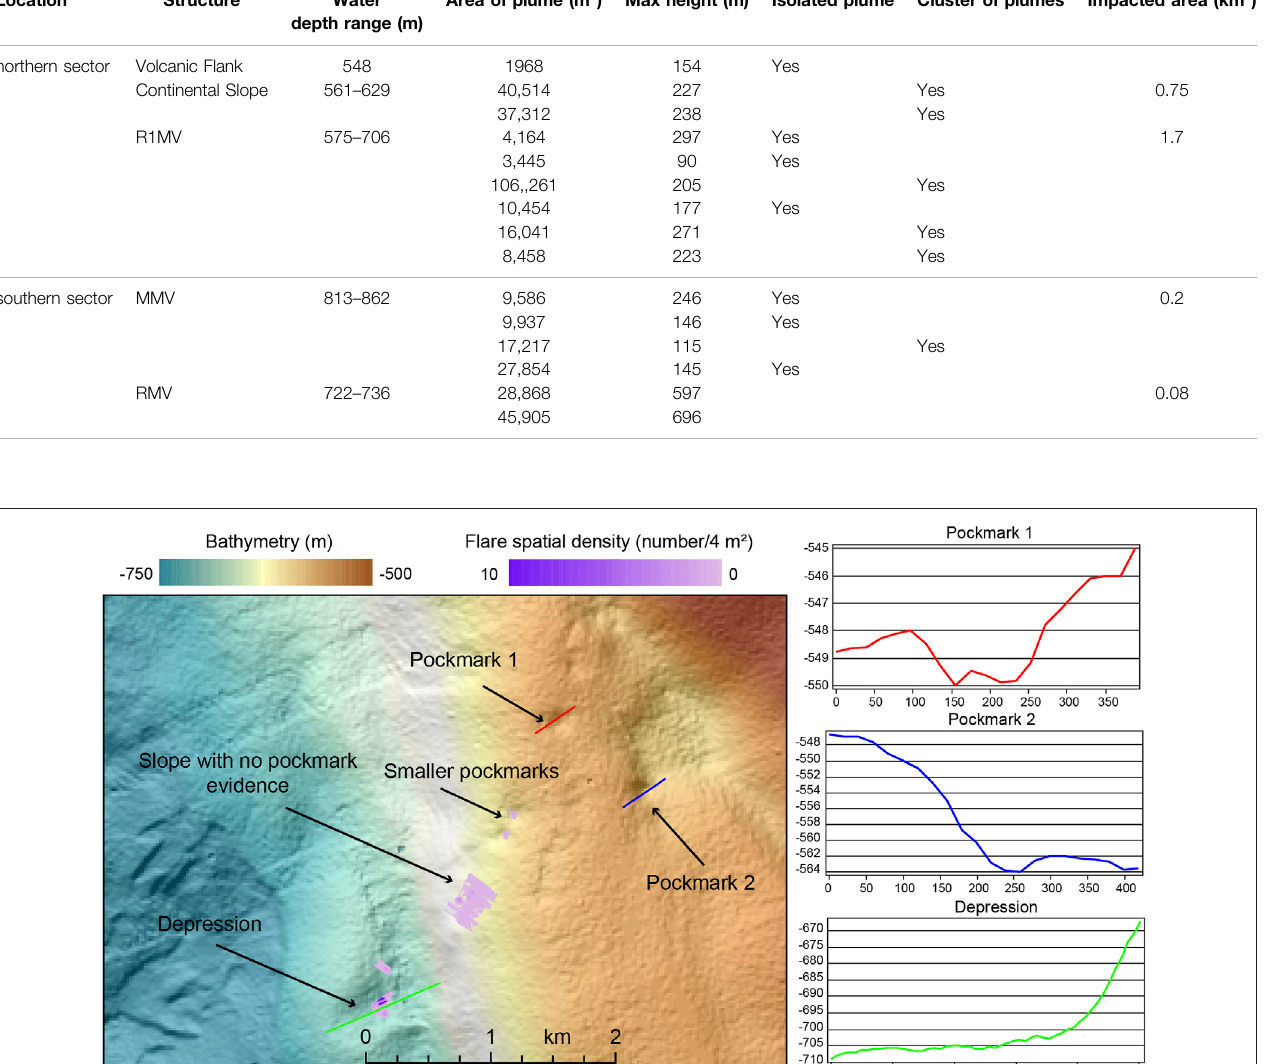
Frontiers in Earth Science |